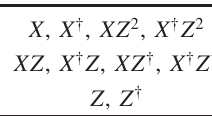
TABLE I. Conversion from single-qubit Pauli operators to four-dimensional generalized Pauli operators. When a syndrome measurement is performed, a Pauli operator is converted to each of the generalized Pauli operators in the right-hand column with equal